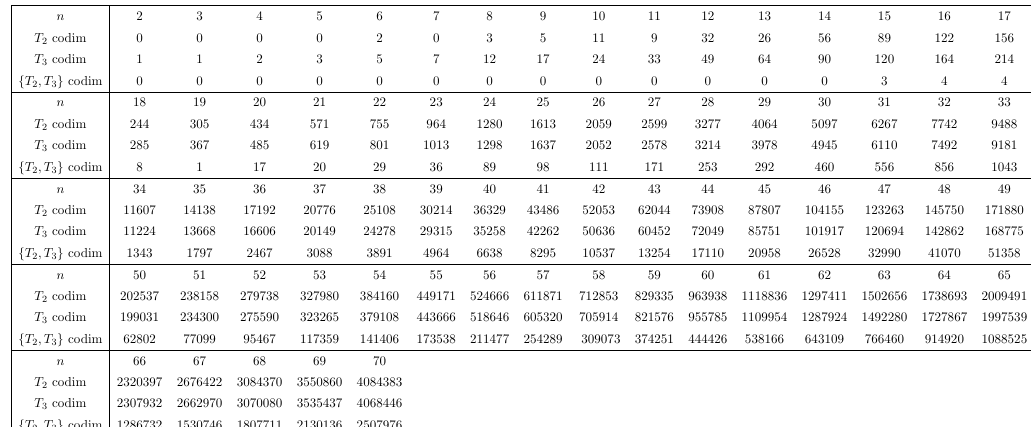
2 , for T 3 , and then for f T 2 ; T 3 g for n = 2